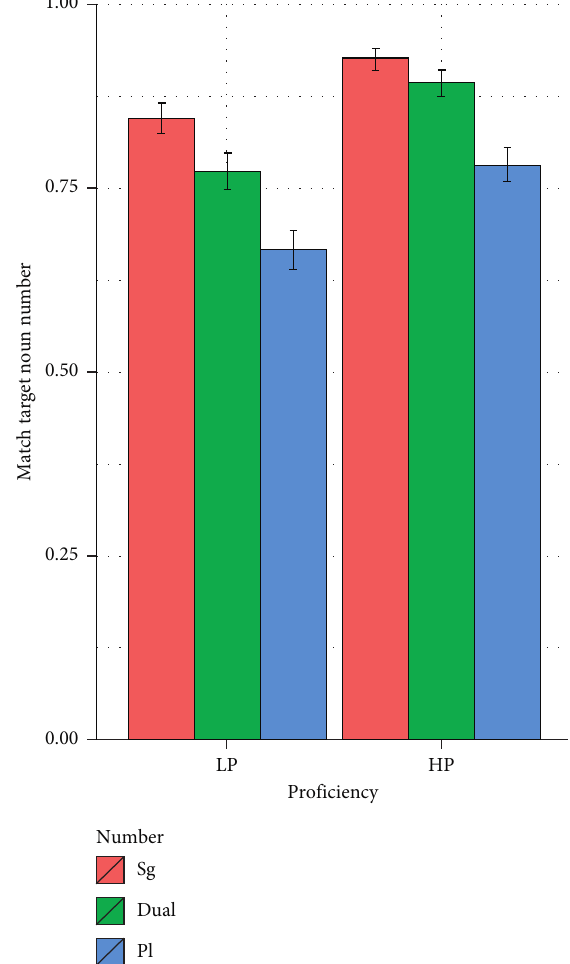
Figure 7: Correct mean % for noun inflection on the compre- hension task by proficiency and